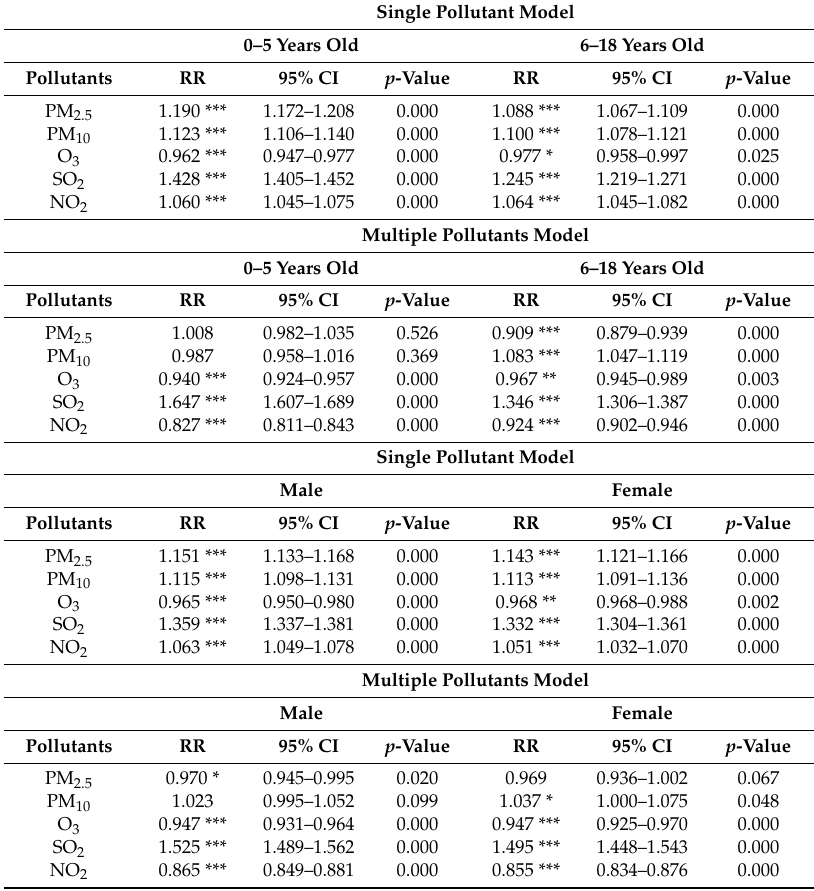
Table 4. Relative risk of asthma hospitalization based on air pollutants, stratified by age and gender. Single pollutant model vs. multiple pollutants